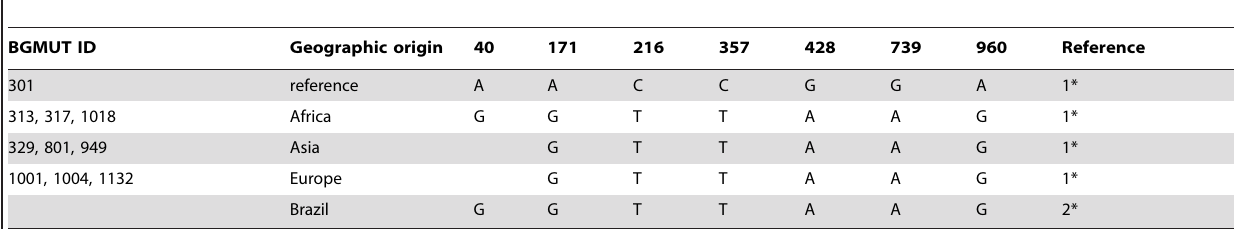
Table 4. Mutations found in exon 2 of the FUT2 gene of people from different continents and of the population studied.